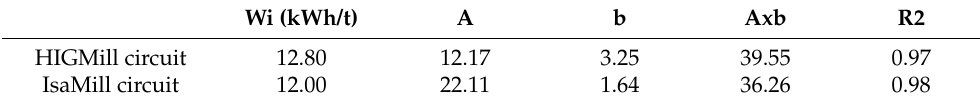
Table 7. Work indices and breakage parameters of the circuit feed